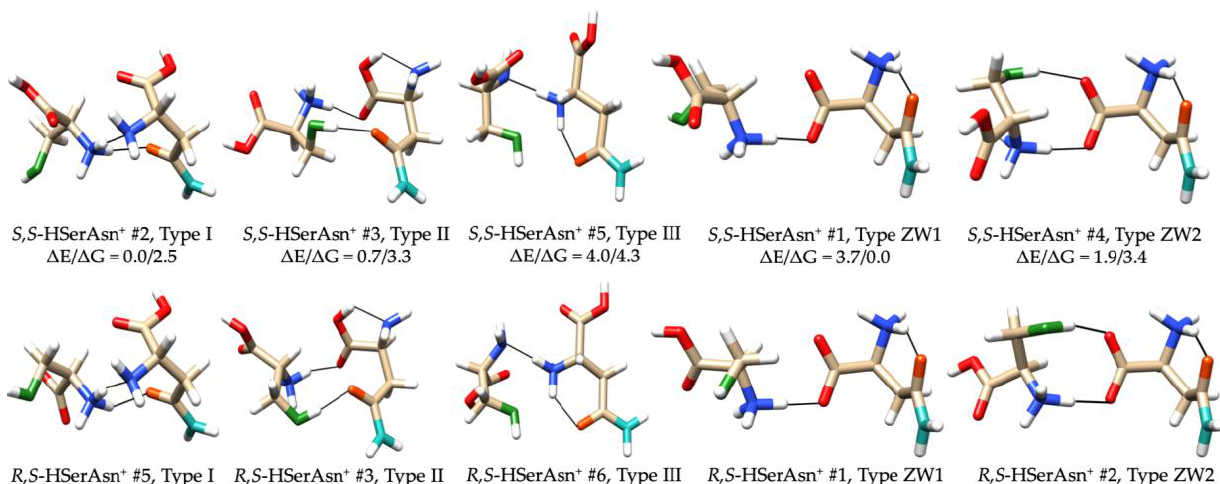
Figure 3. Type I, II, III, and ZW binding topologies of S,S -HSerAsn + and R,S -HSerAsn + . The geometries shown are the most stable isomers in each type. The monomer subunit on the left is S- or R-Ser, while the one on the right is S-Asn. The relative ZPE corrected electronic energy (ΔE) and Gibbs free energy (ΔG) at room temperature in kJ mol -1 at the B3LYP- D3BJ/def2-TZVP level of theory are included. The ranking #1, #2, etc., is based on ΔG and is done for the homo- and